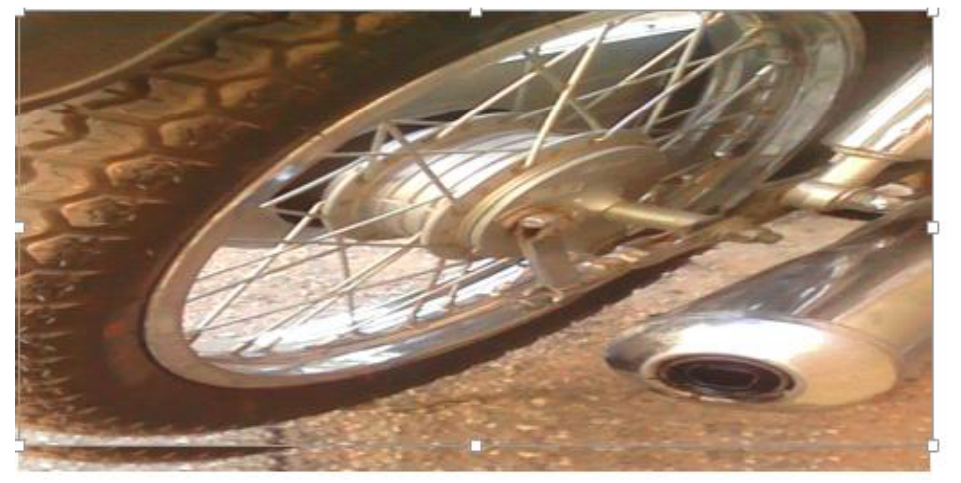
Figure 1: The rear motorcycle wheel